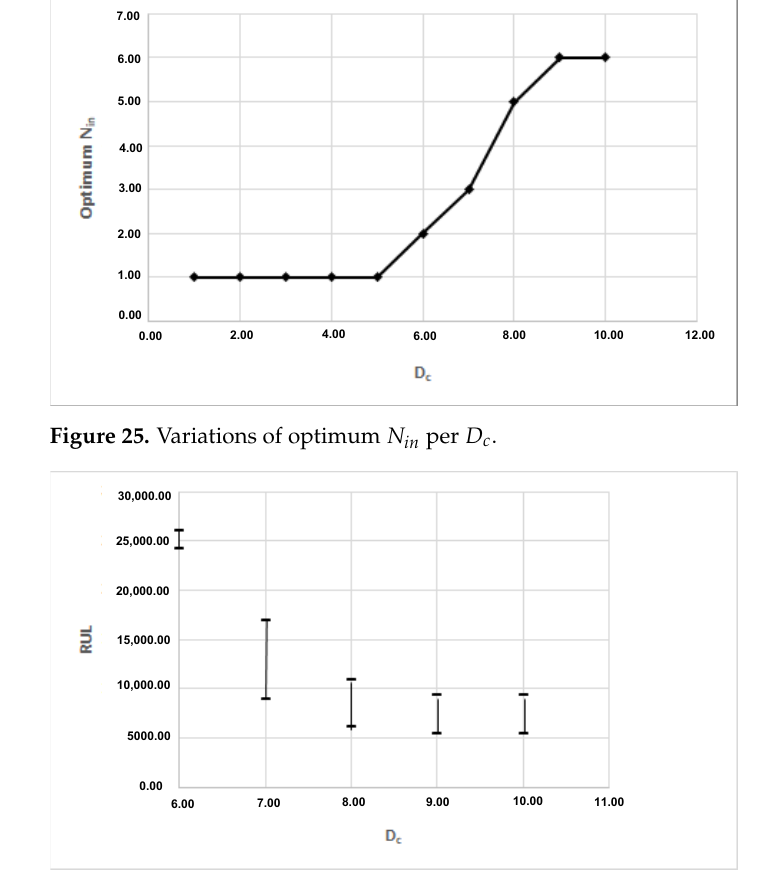
, RUL lim sup ] per D c inf